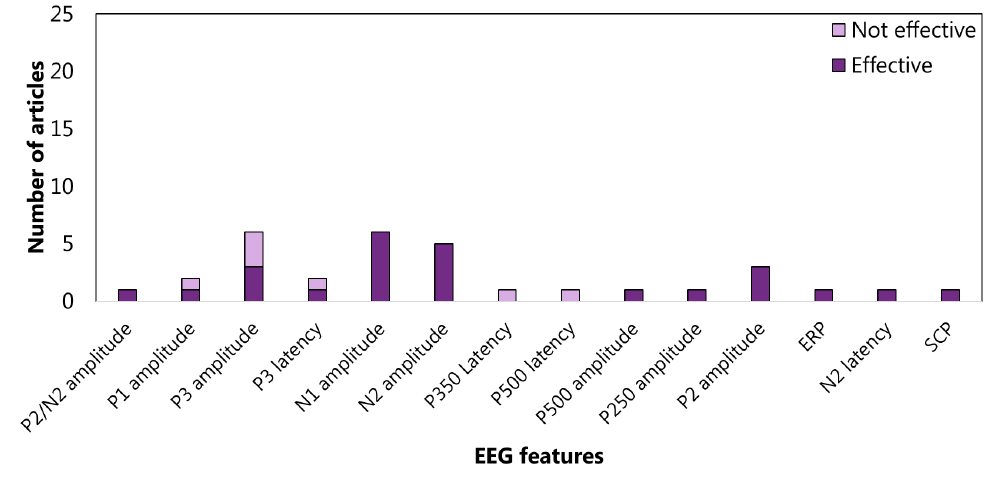
Figure 10. Articles focusing on the relationship between response inhibition and EEG features from time domain. P300 and N100 amplitudes are the features most studied. As far as P300 is concerned, three articles verified (effective) the relationship, and three articles did not (not effective), while all six articles considered verified the effectiveness of N100. ERP: event-related potential; SCP: slow cortical